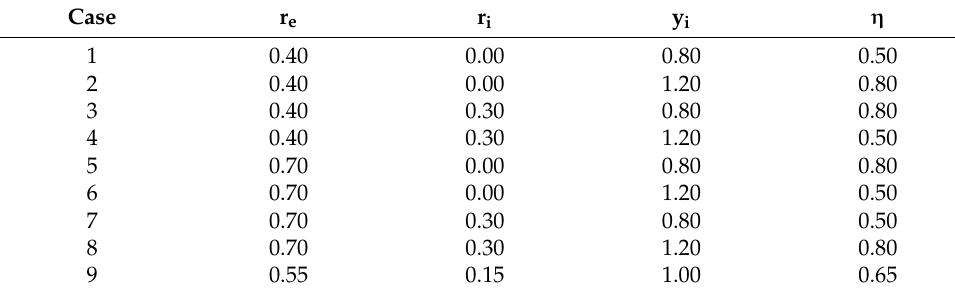
Table 4. Fractional-Factorial